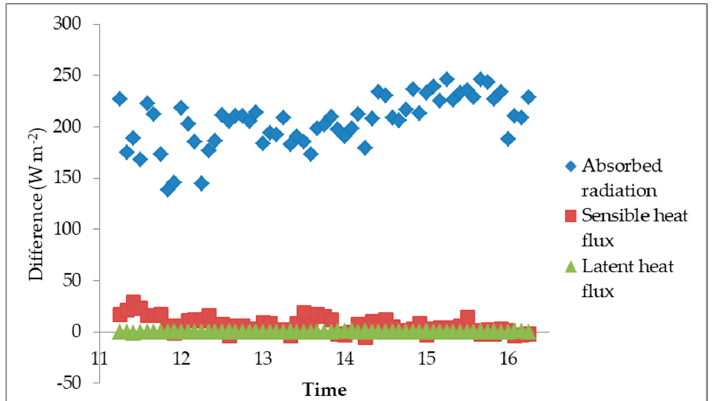
Figure 8. Median values of the difference between the strategy and reference site for absorbed radiation, sensible heat flux, and latent heat flux. Values are from the building shading strategy in the residential setting.